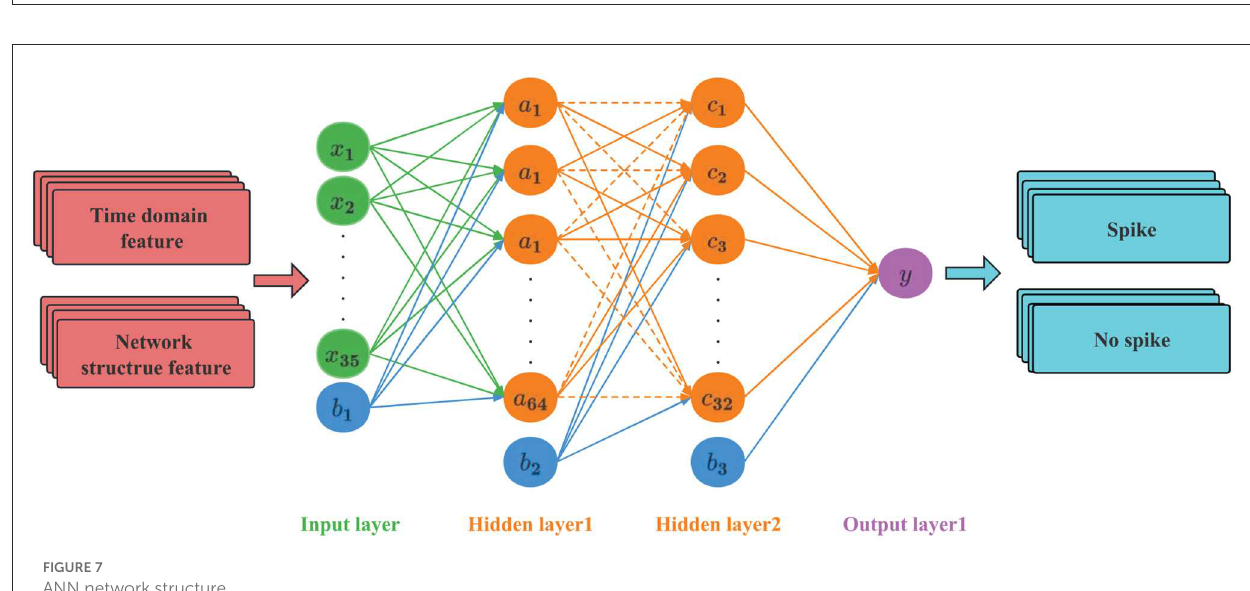
FIGURE7 ANN network